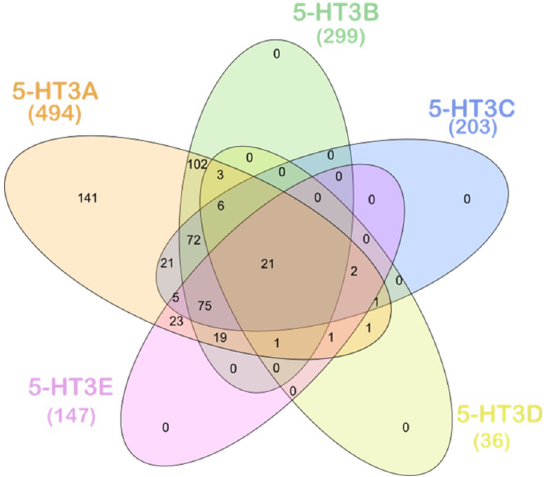
Fig 1. Venn diagram summarising the number of 5-HT 3 receptor A, B, C, D and E subunit sequences identified in different phyla from the animal kingdom. A detailed breakdown of subunit distribution is listed in S2 Table. The figure contains the numbers of B, C, D and E subunits for those species that also contain subunit A, thus our dataset by definition contained zero (0) sequences with only B, C, D, or E